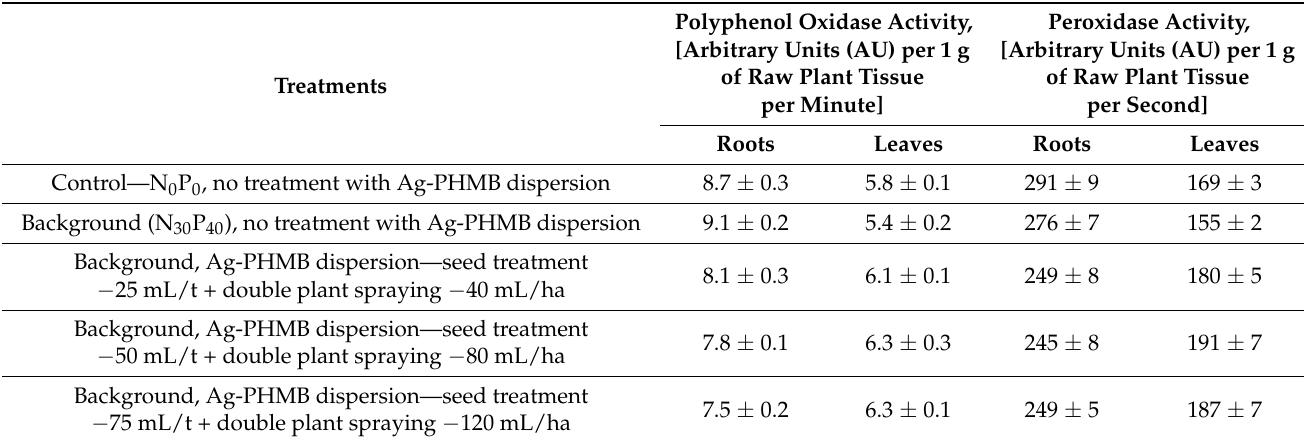
Table 2. Influence of treatments with aqueous dispersion of PHMB-stabilized silver NPs (Ag-PHMB) on the activity of PPO and peroxidase enzymes in the roots and aboveground parts of soybean plants (average values for 2020), confidence probability, p =